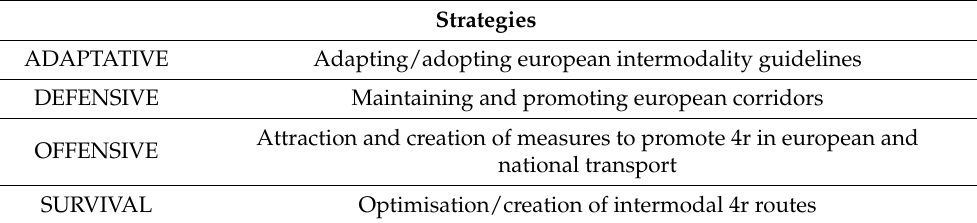
Table 2. Strategies. Source: Own elaboration. Strategies ADAPTATIVE Adapting/adopting european intermodality guidelines DEFENSIVE Maintaining and promoting european corridors Attraction and creation of measures to promote 4r in european and OFFENSIVE national transport